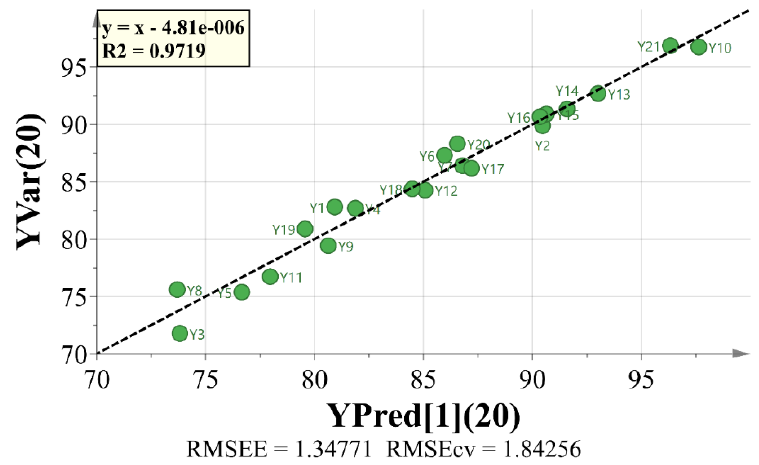
Figure 4. Graphical representation of OPLSR model—calibration model.